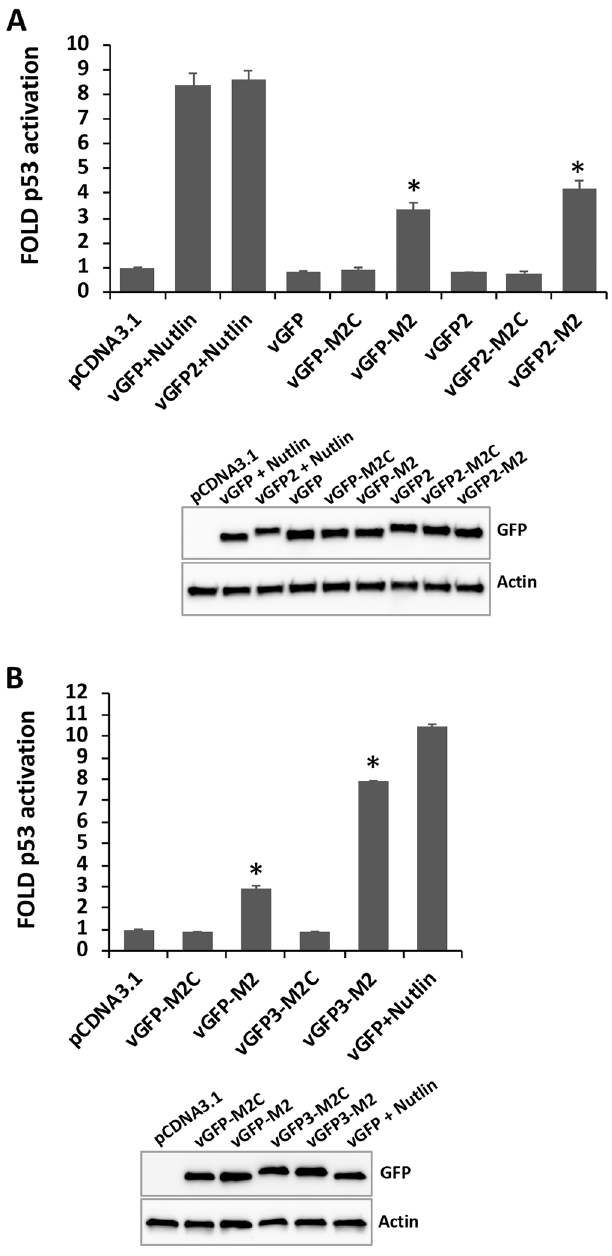
Figure 6. Targeted disruption of the Mdm2-p53 interaction in cells. T22 cells were transfected with indicated vGFP display constructs and p53 reporter gene activity measured as fold over control (pcDNA3.1 vector only). n = 3 ± SD. Small molecule Mdm2 inhibitor Nutlin 3a used as positive control. Respective expression levels of constructs shown in Western blots below. *p < 0.01 compared to vGFP-M2C/vGFP2-M2C/vGFP3-M2C (Student’s